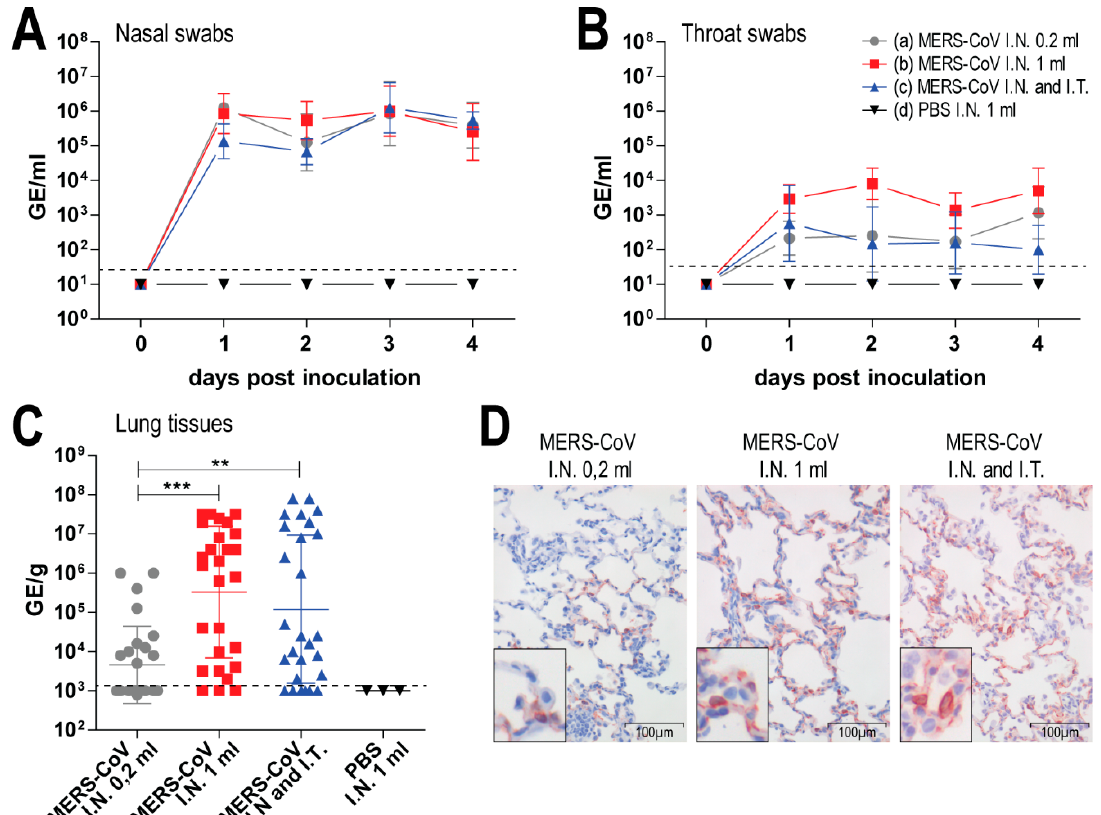
Figure 2. Middle East respiratory syndrome coronavirus (MERS-CoV) inoculation in rabbits with di ff erent routes and volumes. Three New Zealand rabbits were each infected either with (a) 200 µ L of 1 × 10 6 TCID 50 / mL MERS-CoV intranasal (I.N.); (b) 1 mL of 1 × 10 6 TCID 50 / mL MERS-CoV I.N.; (c) 200 µ L of 1 × 10 6 TCID 50 / mL MERS-CoV I.N. combined with 3 mL of 4 × 10 6 TCID 50 / mL MERS-CoV intratracheal (I.T.); or (d) 1mL of PBS I.N as negative control. These animals were sacrificed at day 4 post inoculation. Viral RNA shed by the MERS-CoV-inoculated rabbits in the nasal swabs ( A ) and throat swabs ( B ) are reported in genome equivalents per ml (GE / mL). Viral RNA detected in the lungs of these rabbits are reported in genome equivalents per gram tissues (GE / g). Dashed lines depict the detection limit of the assays. All error bars represent standard deviations. Statistical analysis is performed using Kruskal wallis test (**, p value < 0.01; ***, p value < 0.001). Representative figures of immunohistochemistry detecting MERS-CoV nucleoprotein (displayed in red) in the lungs of these rabbits were taken at a 200 × magnification ( D ). All MERS-CoV-inoculated rabbits shed a relatively equal amount of viral RNA in the nasal and throat swabs ( A , B ). However, there was significantly less viral RNA in the lungs of rabbits in the group (a) in comparison to the other MERS-CoV-inoculated groups ( C ). A similar finding is observed in our immunohistochemistry analysis detecting MERS-CoV nucleoprotein (displayed in red) in the lungs of these rabbits ( D ). Pictures were taken in 200 × magnification. The amount of viral RNA is displayed either in genome equivalent per mL (GE / mL) or per gram tissues (GE / g). Dashed lines depict the detection limit of the assays. All error bars represent standard deviations. Statistical analysis is performed using Kruskal–Wallis test (**, p value < 0.01; ***, p value < 0.001).